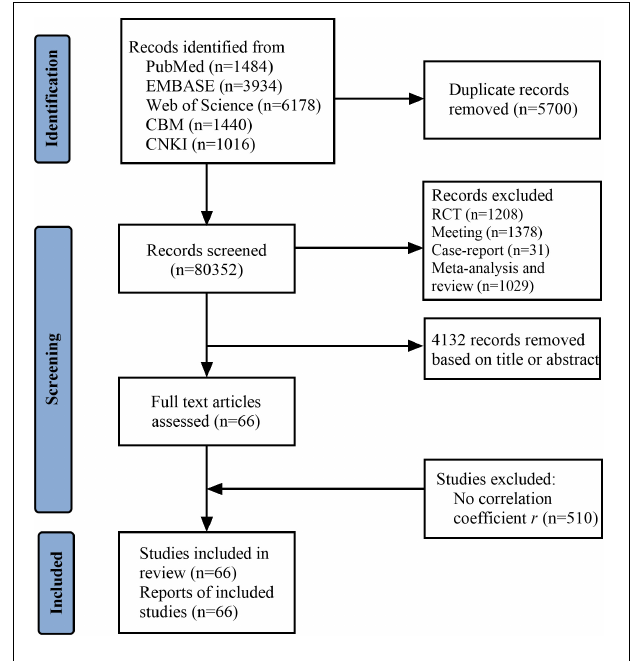
FIGURE 1 | Study flow